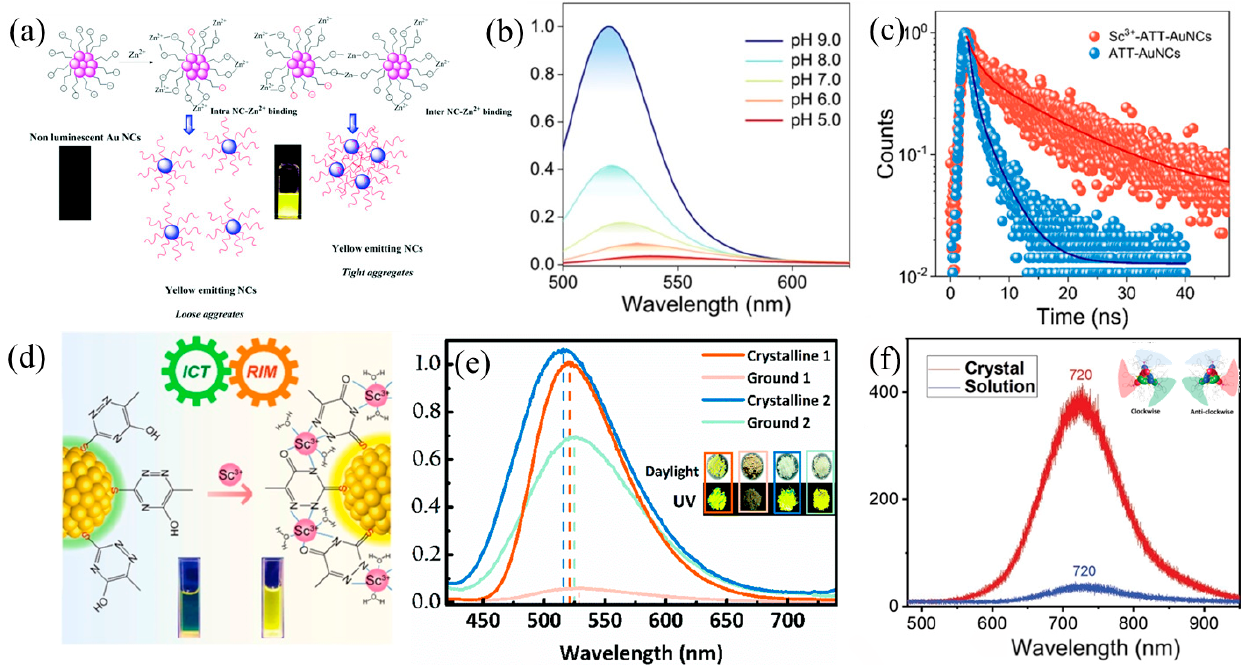
Figure 4. ( a ) Graphic illustration of self-assembly based on coordination effect of Zn 2+ ions with different binding levels. Reprinted/adapted with permission from Ref. [32]. 2017, copyright Royal Society of Chemistry. ( b ) Photoemission spectra of ATT-AuNCs in different pH buffers. ( c ) Photolumi- nescence decay of ATT-AuNCs and Sc 3+ -ATT-AuNCs. ( d ) The binding model of Sc 3+ to